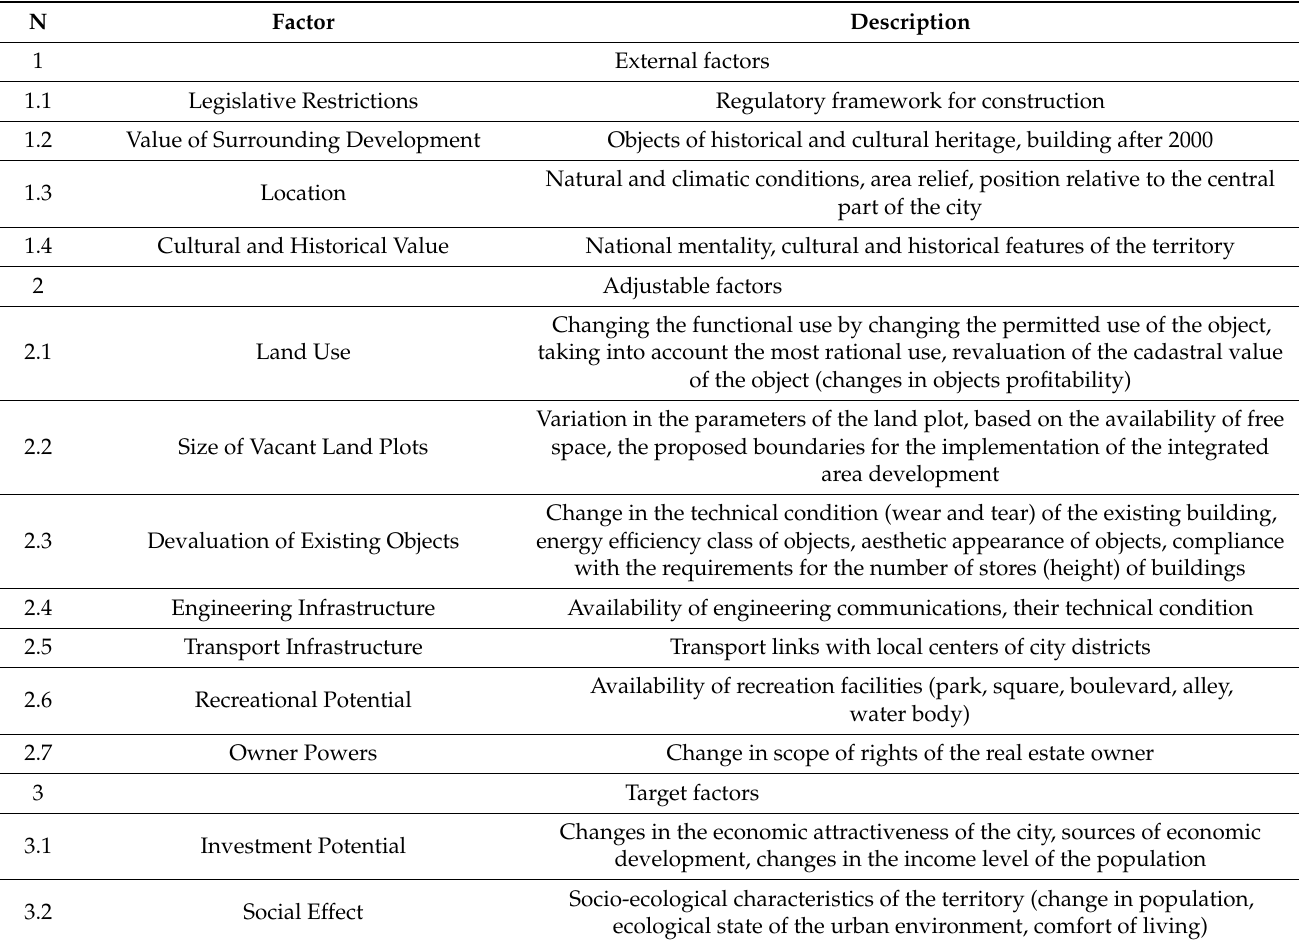
Table 2. Factors that determine the urban areas’ development